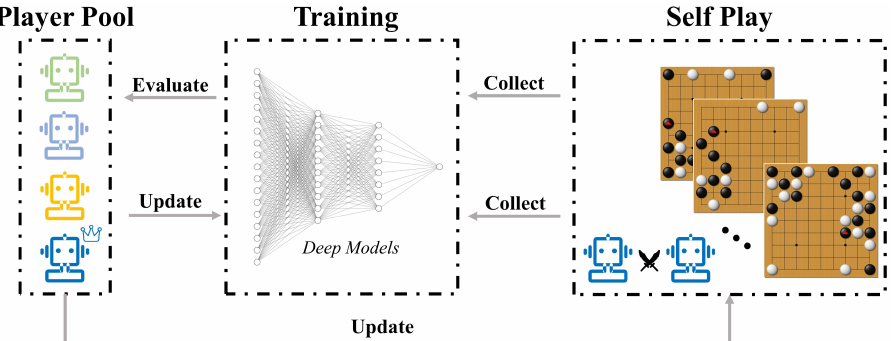
Figure 1. AlphaZero’s pipeline. Self-play games’ data are continuously generated and collected to train deep neural networks. After each round of training, the new model is compared with the previous model. If the new model defeats the previous model, the training process continues. Otherwise, the previous training result is discarded and the previous step is